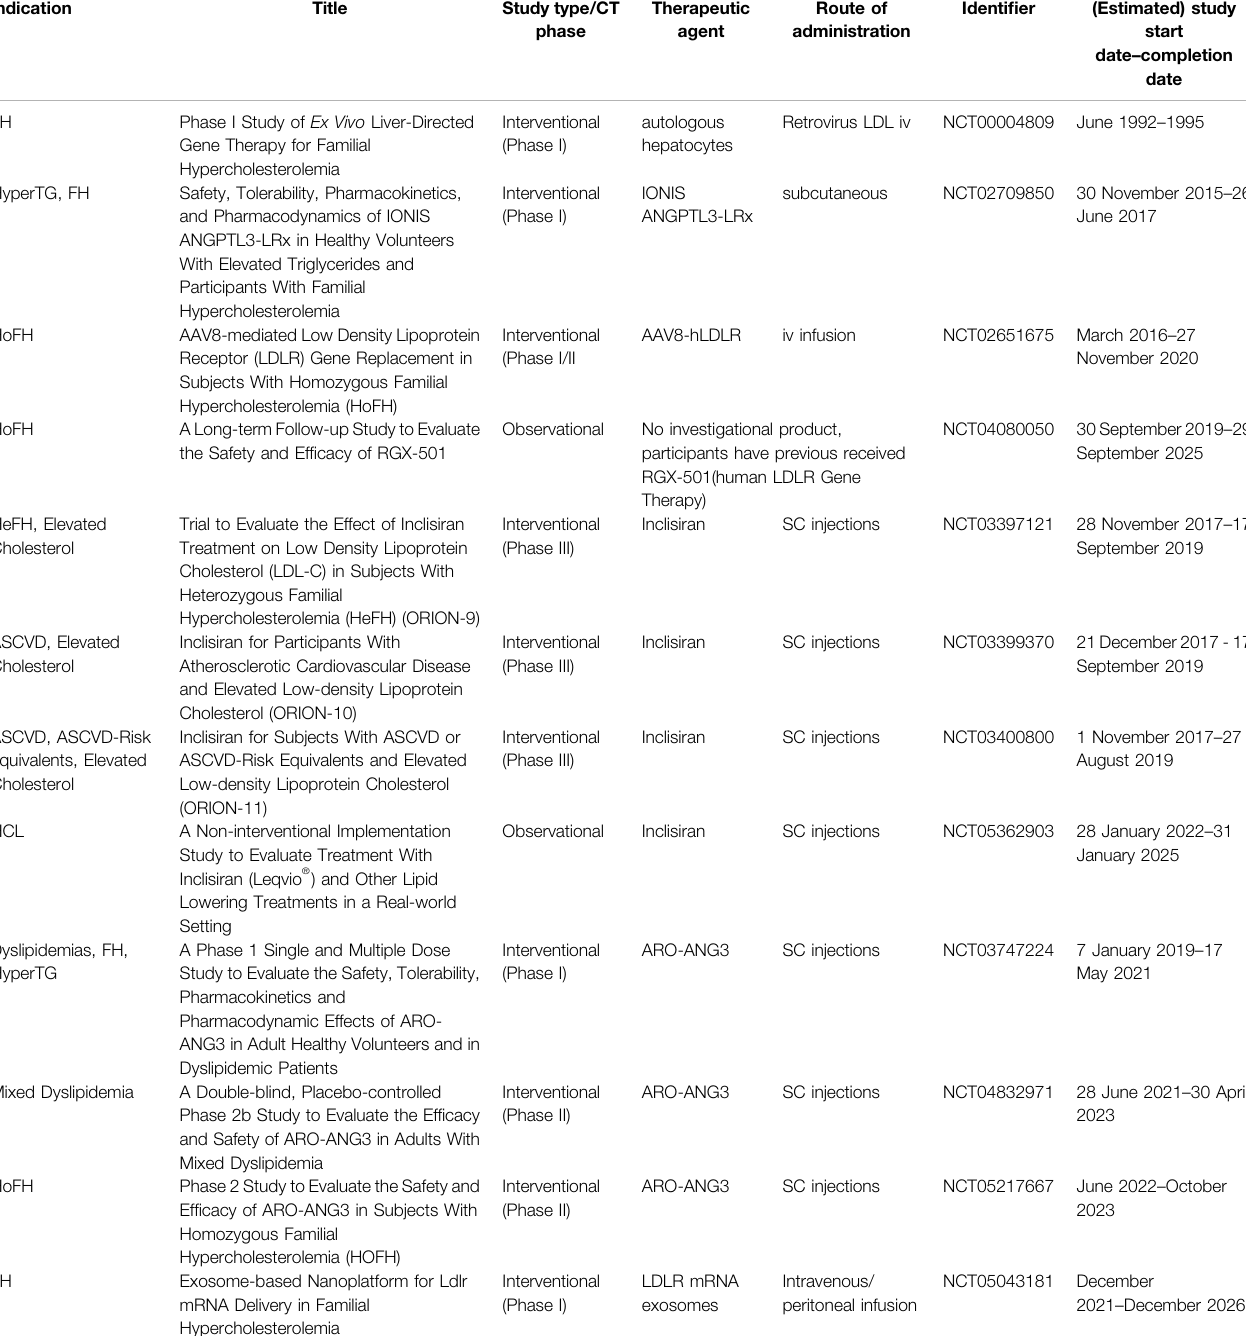
TABLE 1 | Registered clinical trials of RNA-based therapy and gene therapy for RH (clinicaltrials.gov; search date: 2022/05/11).